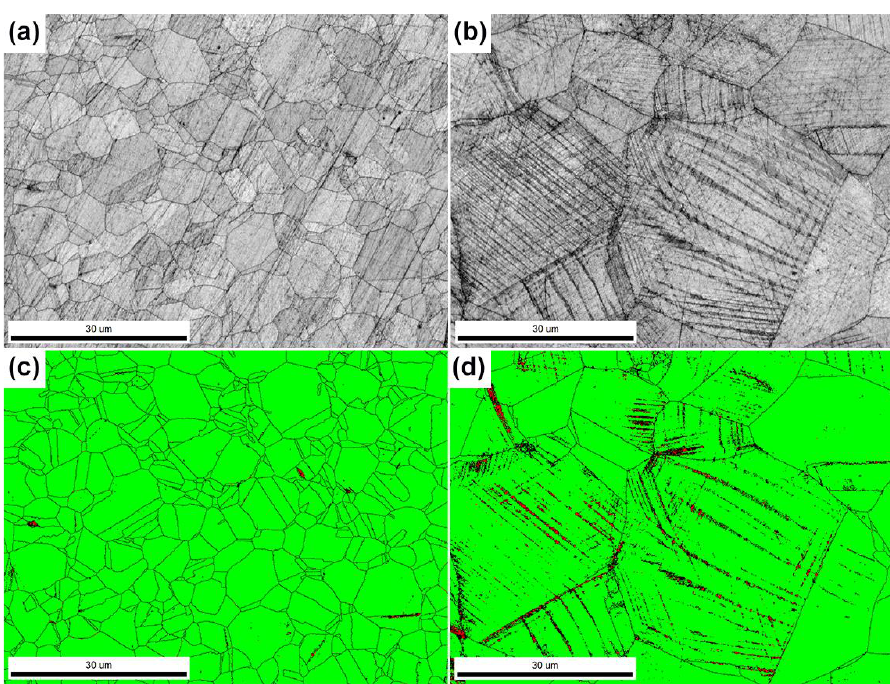
Figure 1. Electron back scattered diffraction (EBSD) micrographs of the experimental steels: ( a , b ) present the band contrast micrograph of CR-MASS and HR-MASS, respectively; ( c , d ) display the color - coded phase maps (austenite: green, martensite: red) in accordance to ( a ) and ( b ), respectively.